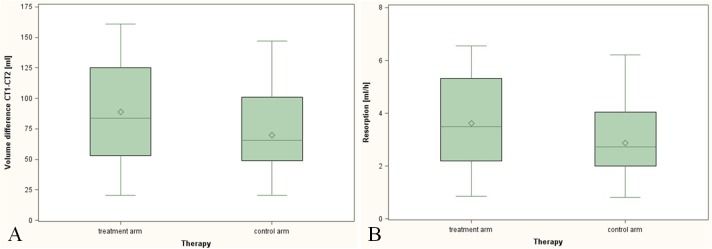
Box plots for the mean volume change of pneumocephalus (A) and air resorption rate (B) between CT1 and CT2.